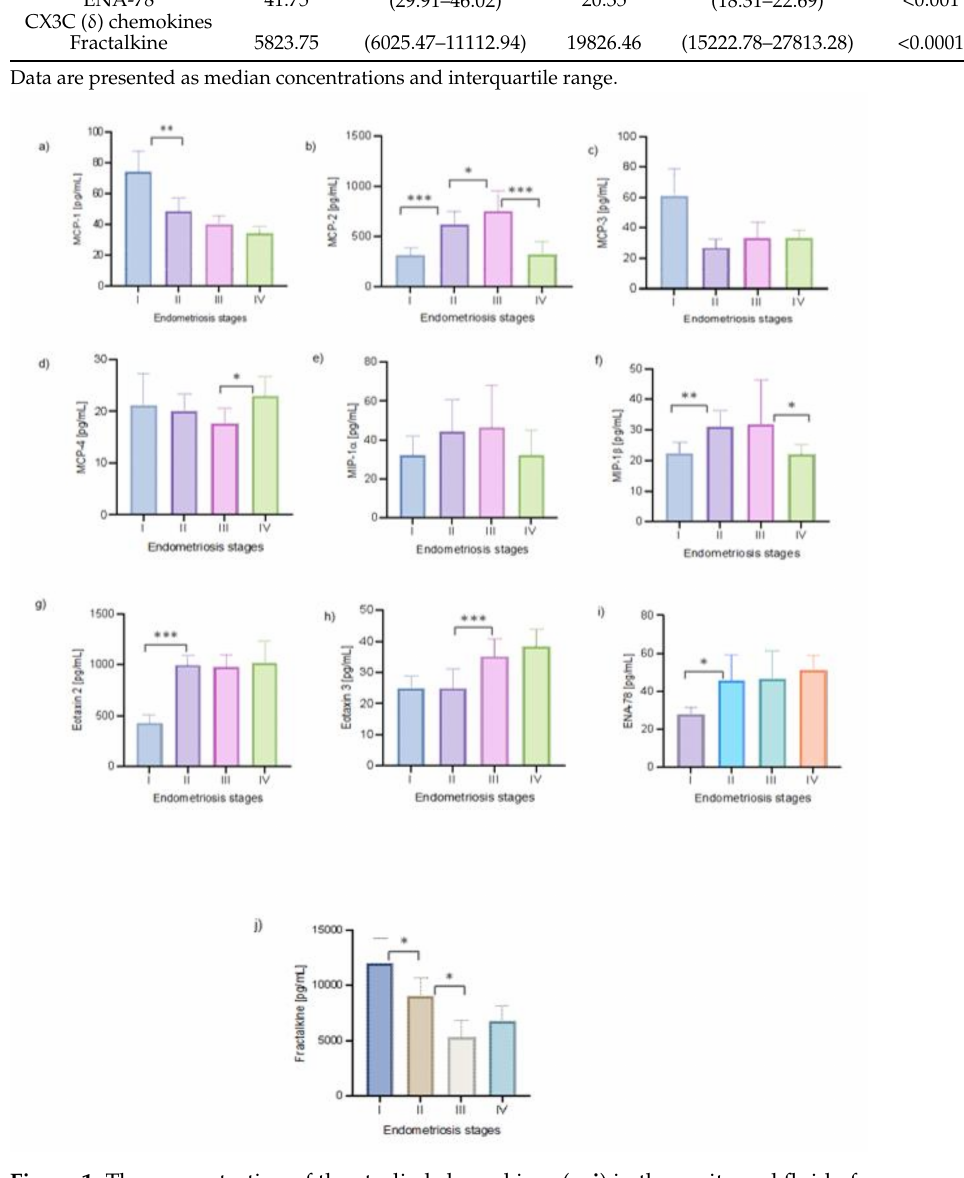
Figure 1. The concentration of the studied chemokines ( a – j ) in the peritoneal fluid of women with endometriosis at progressive